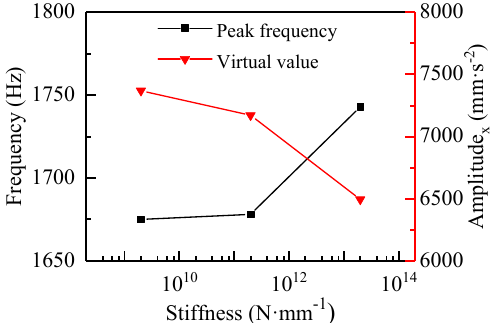
Figure 12. The peak frequency and RMS in x-direction under different stiffness values with the μ 3 friction coefficient.